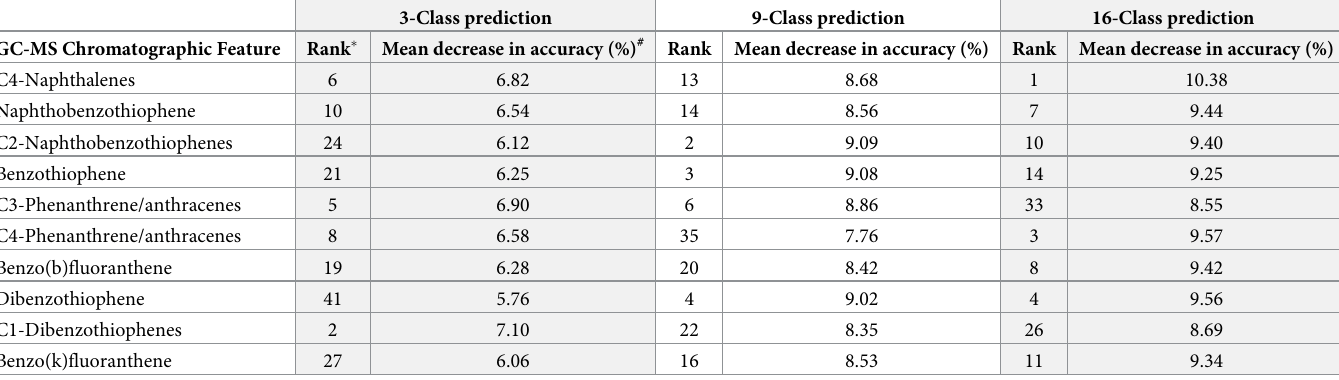
Table 6. Top 10 most informative GC-MS chromatographic features with respect to the classification accuracy of the petroleum substances. See S3–S5 Tables for the list of all chromatographic features and their respective ranks in each analysis.